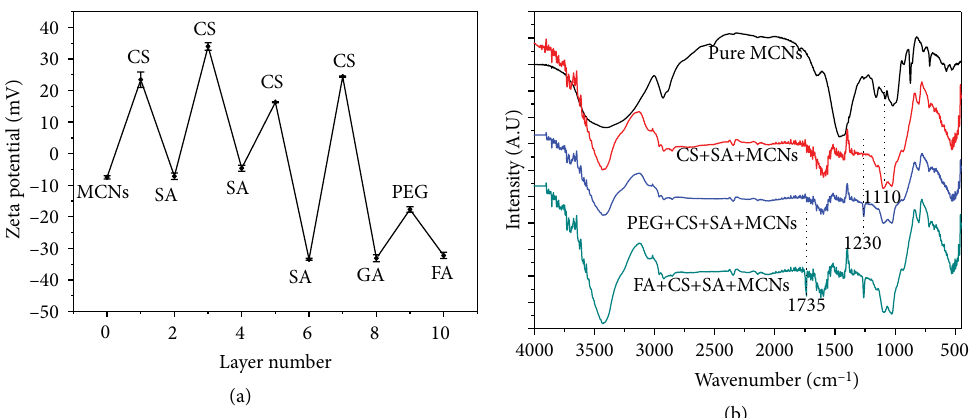
nano-particles assembled layer by layer. (MCNs: 3